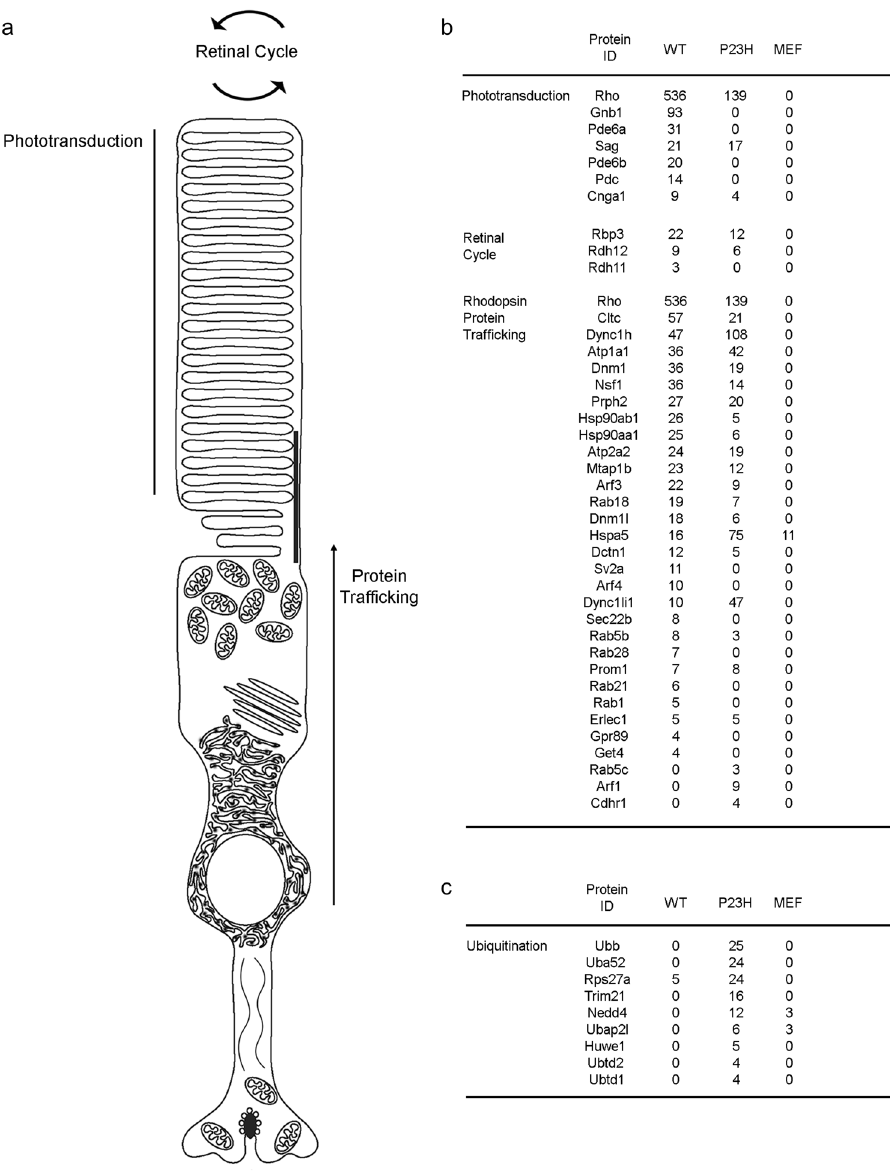
Figure 2. The P23H rhodopsin interactome contains decreased rod photoreceptor function proteins and increased ubiquitination proteins compared to wild-type rhodopsin interactome. ( a ) Graphic shows 3 functions unique to rod photoreceptor cells—phototransduction, vitamin A/retinal cycle, and rhodopsin protein trafficking ( b ) Spectral counts of individual proteins associated with phototransduction, retinal cycle, and rhodopsin protein trafficking identified in wild-type and P23H rhodopsin protein interactome. Spectral counts from mouse embryonic fibroblast (MEF) lysates anti-rhodopsin immunoprecipitates were analyzed by LC–MS/MS samples as a control. ( c ) Spectral counts of proteins associated with ubiquitination from wild-type rhodopsin interactome, P23H rhodopsin interactome, and MEF